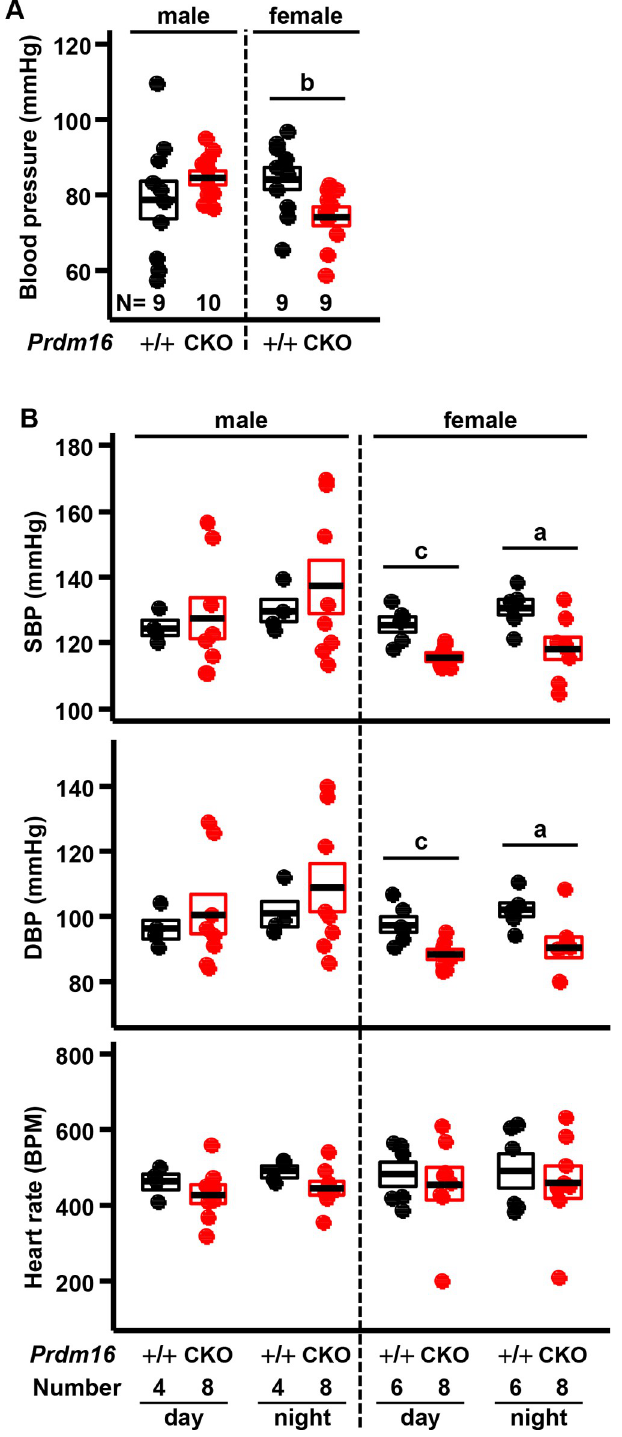
Fig 1. Decreased BP in female mice with cardiac-specific inactivation of Prdm16 . (A) BP was measured intra- arterially under anesthesia separately in 5-month-old male and female control (+/+, Prdm16 +/+ ; Myh6-Cre) and cardiac-specific knockout mice of Prdm16 (CKO, Prdm16 flox/flox ; Myh6-Cre), termed Prdm16 CKO . (B) SBP, DBP, and heart rate were measured via a telemetric implant for 24 hours (day and night) during conscious, unrestrained status 1 week after implantation. Error bars, mean ± SEM; number (N), number of mice; statistical significance by student’s t - test, a ( P < 0.05), b ( P < 0.01), and c ( P < 0.005).